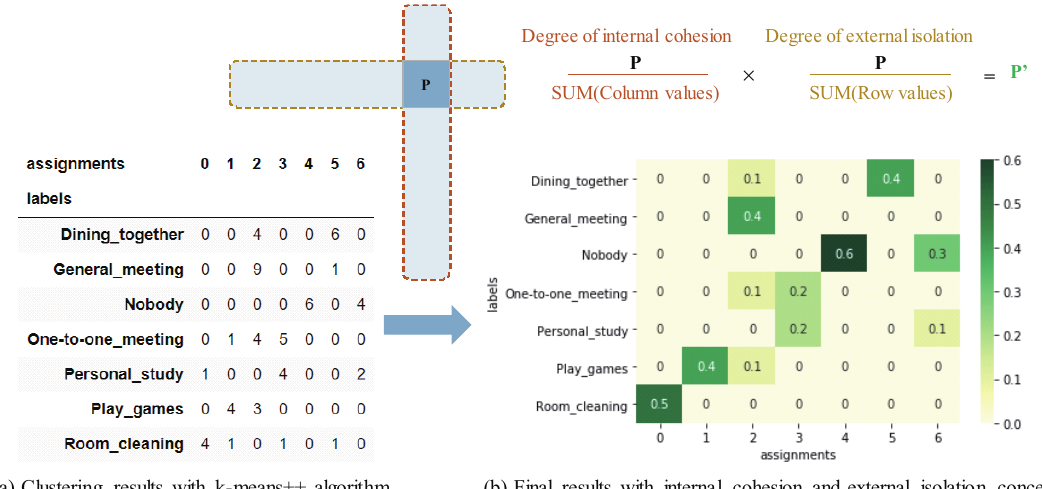
Figure 2. Example of the process for evaluating the capability of cognitive Application Program Interfaces